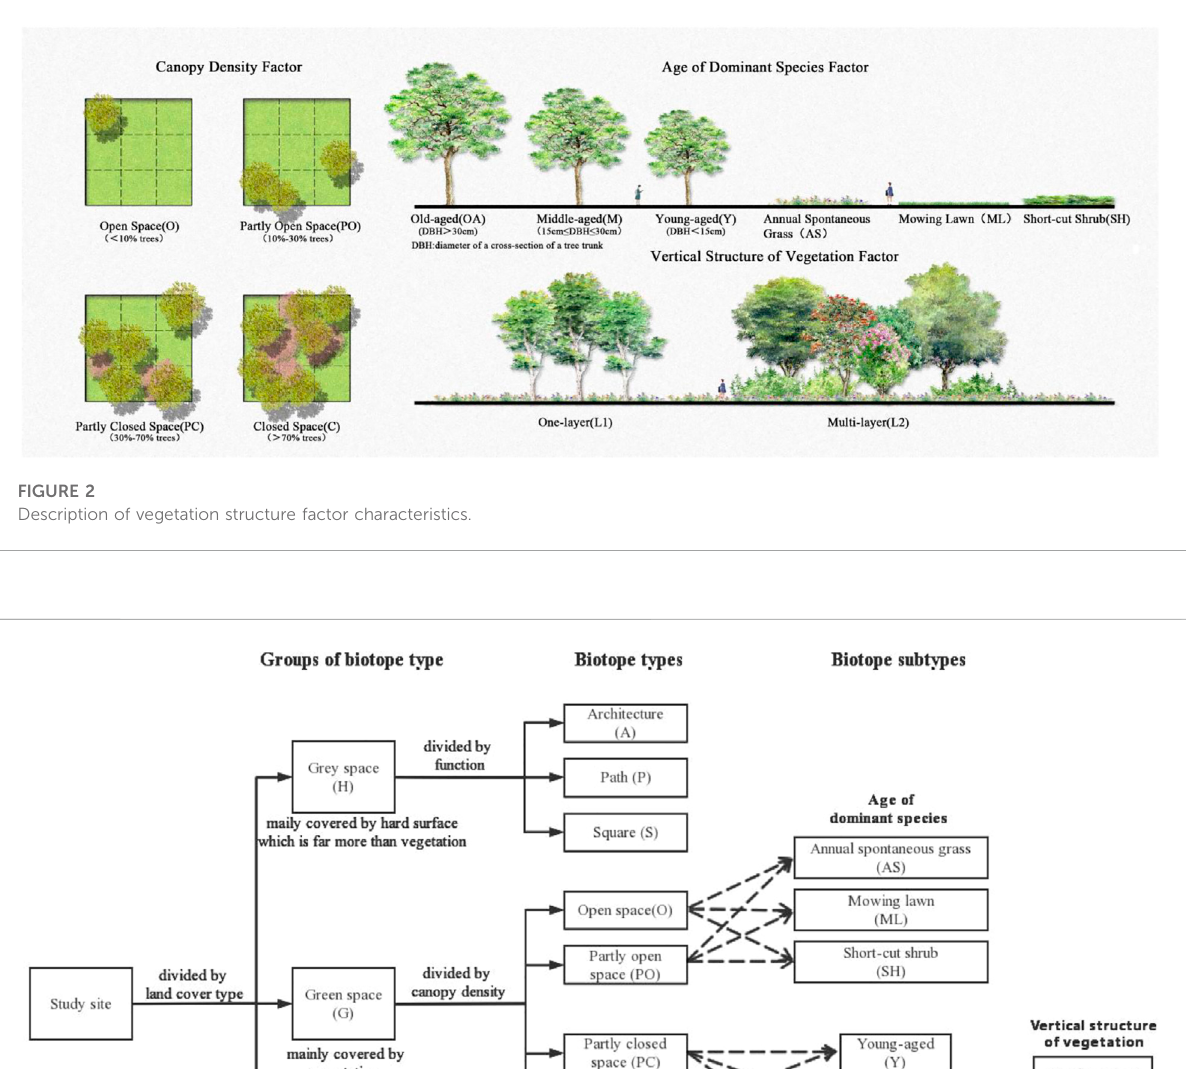
FIGURE 3 Biotope classi fi cation